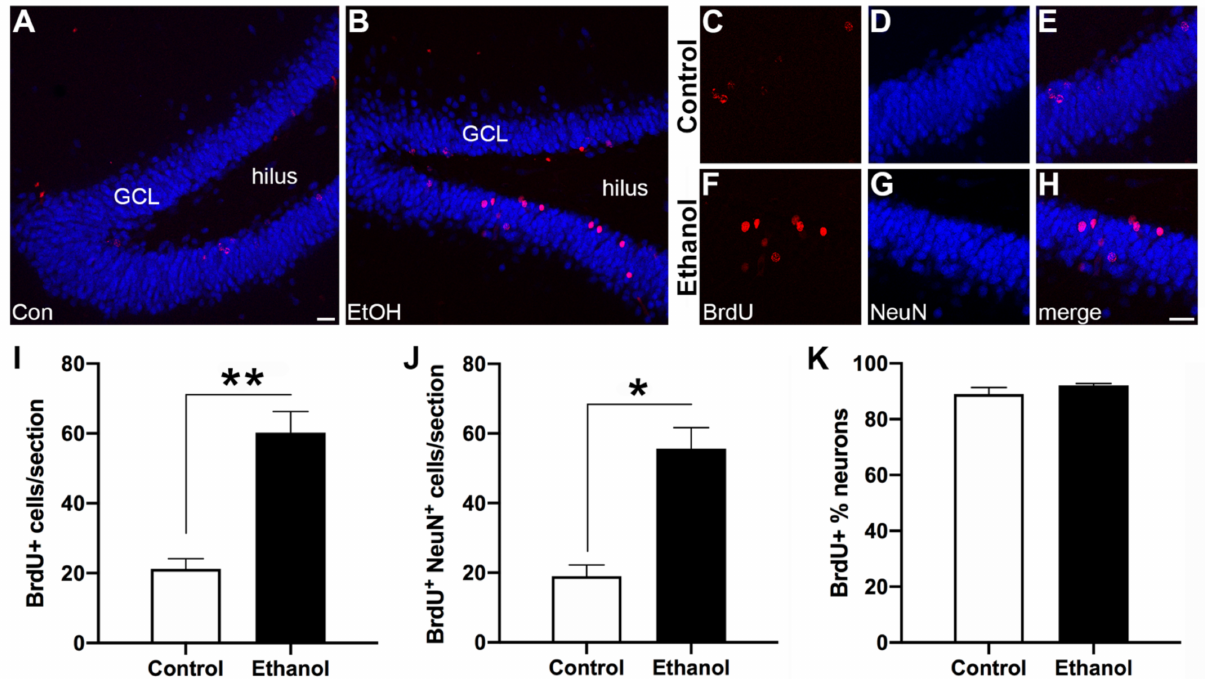
Figure 3. Reactive neurogenesis: Representative images of the dentate gyrus from control ( A ) and ethanol-exposed ( B ) animals at T7 highlighting the distribution of bromodeoxyuridine (BrdU)/Neuronal Nuclei (NeuN) immunoreactivity. Higher magnification images for individual fluorochromes illustrating BrdU+ alone (red), NeuN+ alone (blue), and merged for both a control ( C – E ) and an ethanol-treated ( F – H ) rat. ( I ) Unpaired t-tests revealed significantly more BrdU+ cells and ( J ) more BrdU+/NeuN+ co-labelled neurons in the ethanol-treated animals compared to the controls. ( K ) Of the BrdU+ cells only, there is no significant difference between the ethanol and control groups in the percent of BrdU+/NeuN+ co-labelled neurons. GCL—granule cell layer. Bars represent means ± SEM. * p < 0.05, ** p < 0.01. Scale bars = 40 µ